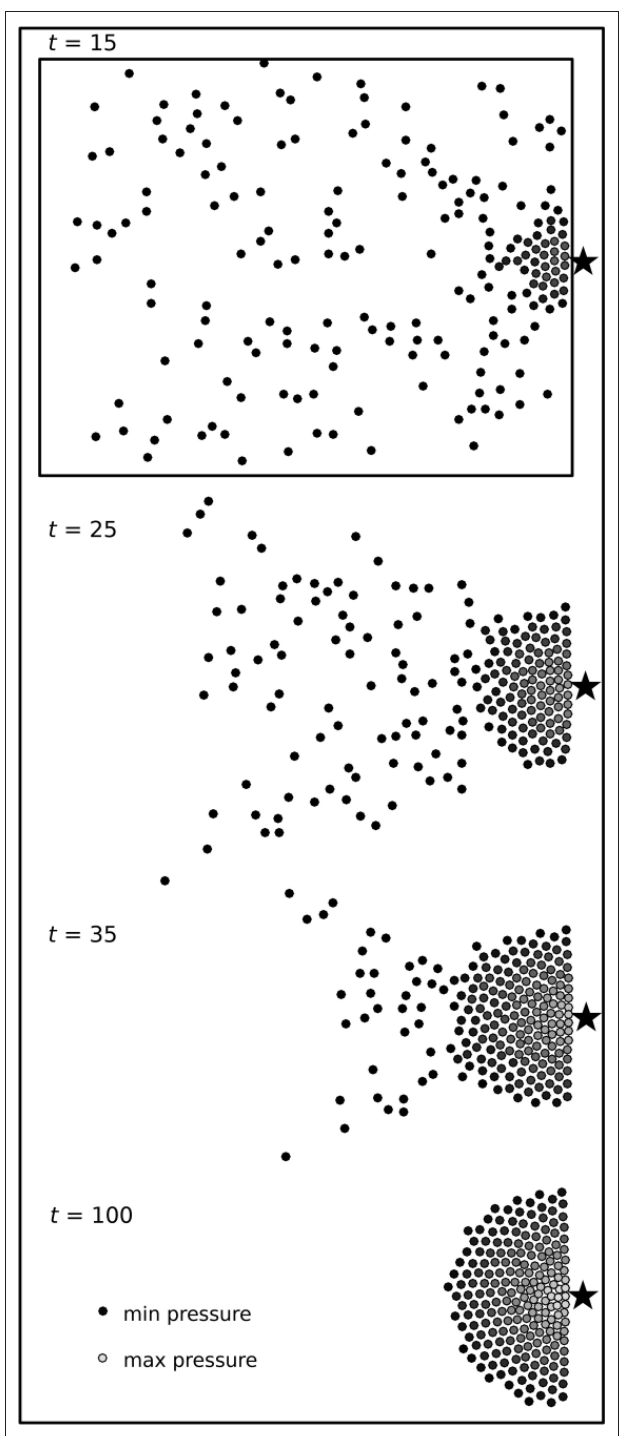
FIGURE 2 | Four screenshots of a typical simulation run for our asocial model of high-density human crowds. Here, we see N 200 SPPs aggregating near = a point of interest P denoted by ⋆ , which is located at the right-most edge of a simulation box. SPPs self-organize into a dense and disordered aggregate, where shading is assigned according to the radial pressure at time t . The rectangular outline for t 15 gives an impressionistic sense of the simulation = box; the true border is taller and somewhat wider.